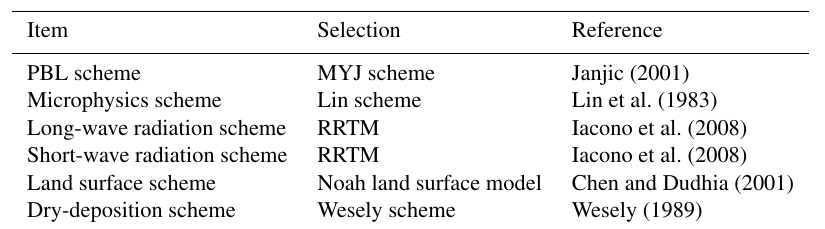
Table 2. Major configuration options of WRF-Chem used for this study. Item